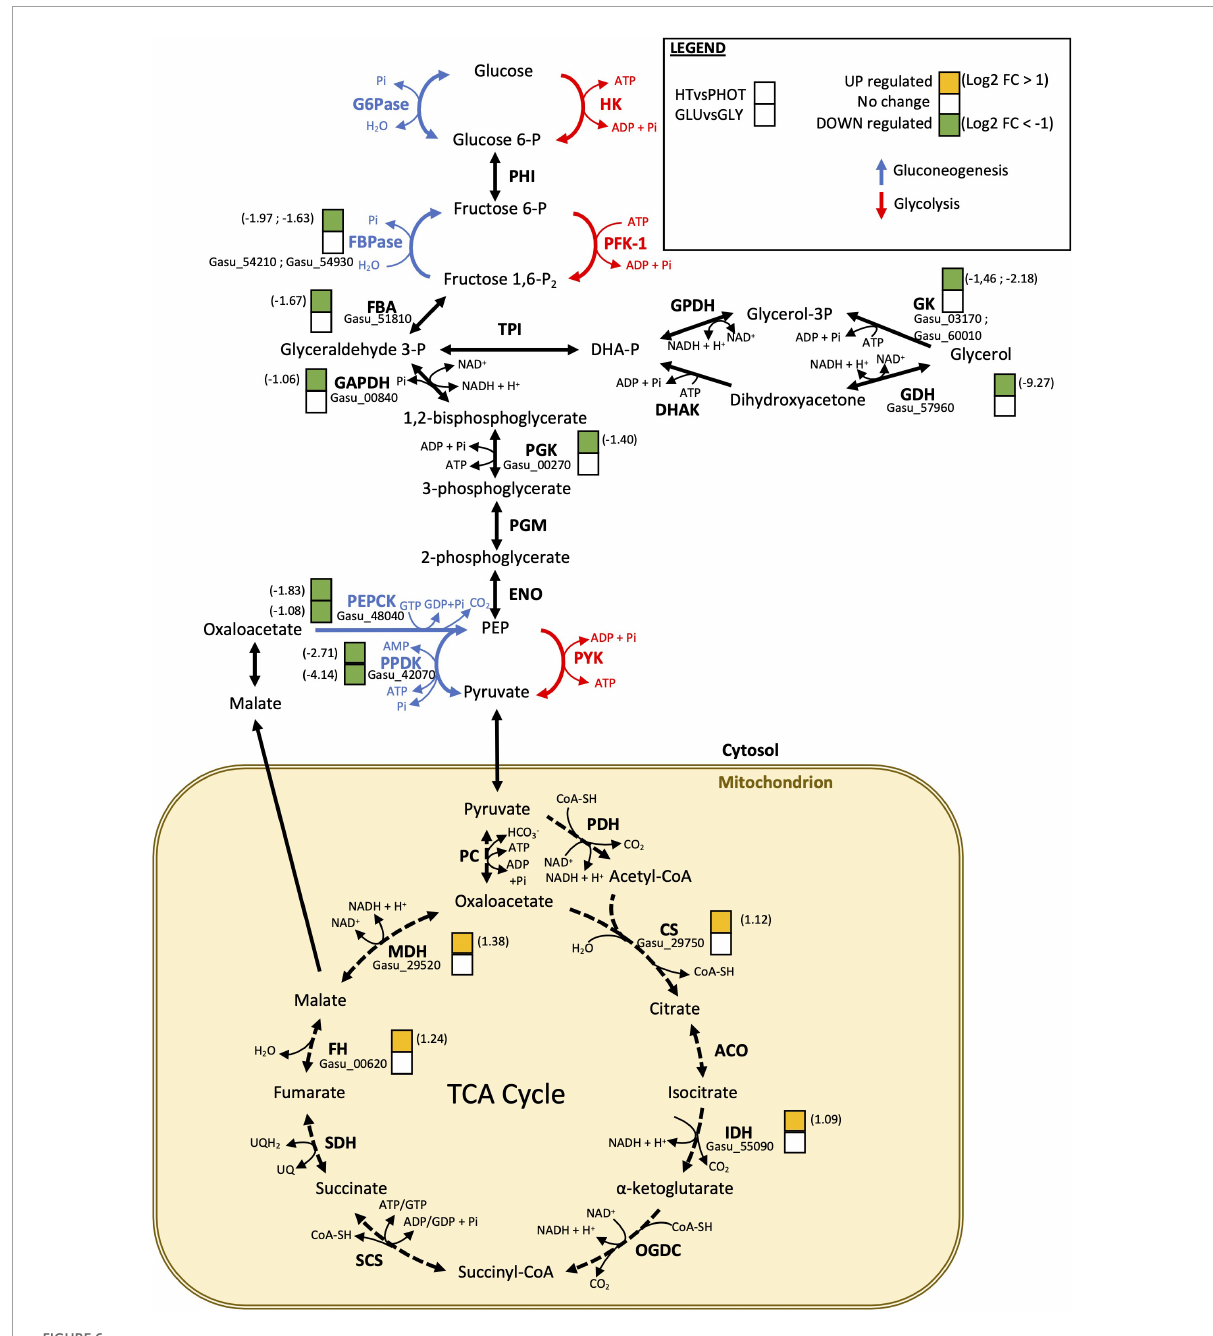
FIGURE6 Schematic representation of glycolysis, gluconeogenesis, and tricarboxylic acid (TCA) cycles. Solid red and blue arrows mark specific reactions of glycolysis and gluconeogenesis, respectively. Cytosol is in white and mitochondrion is in light brown. Enzymes are highlighted and intermediated metabolites are shown in normal letters. Enzymes encoded by differentially expressed genes are marked with two overlapped squares. The one on the bottom refers to glucose compared to glycerol differentially expressed genes and the one on the top refers to heterotrophy compared to phototrophy differentially expressed genes. Green color is for downregulated genes, yellow color for overexpressed genes and white color means no significant differences in gene expression. Log2FoldChange is written on the right or on the left size of the squares when differences are observed. Transcript names are written above enzyme abbreviations. Abbreviations for enzymes: G6Pase, glucose-6-phosphatase; HK, hexokinase; FBPase, fructose 1,6-biphosphatase; PFK-1, phosphofructokinase-1; FBA, aldolase; TPI, triose-phosphate isomerase; GPDH, glycerol 3-phosphate dehydrogenase; GK, glycerol kinase; DHAK, dihydroxyacetone kinase; GDH, glycerol dehydrogenase; GAPDH, glyceraldehyde-phosphate dehydrogenase; PGK, phosphoglycerate kinase; PGM, phosphoglycerate mutase; ENO, enolase; PEPCK, phosphoenolpyruvate carboxykinase; PPDK, pyruvate phosphate dikinase; PYK, pyruvate kinase; PDH, pyruvate dehydrogenase; PC, pyruvate carboxylase; CS, citrate synthase; ACO, aconitase; IDH, isocitrate dehydrogenase; OGDC, α